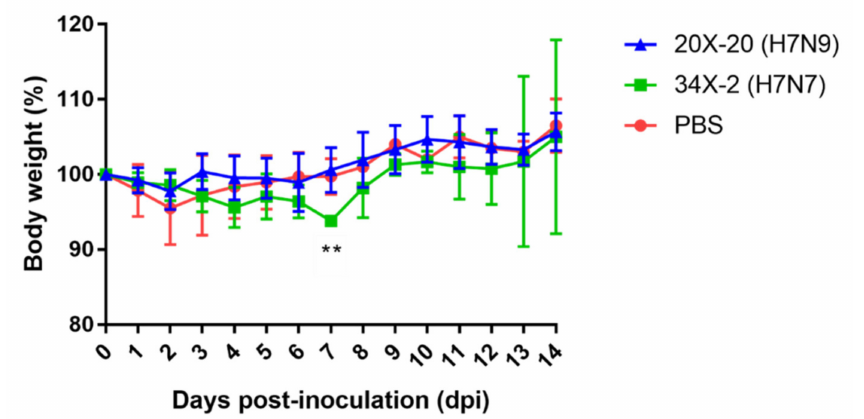
Figure 3. Body weight changes in mice infected with 20X-20 and 34X-2 viruses. BALB/c were intranasally inoculated with 10 7 EID 50 of each virus. The mice were observed for 14 days. The data indicate the mean and standard error of the mean (SEM). The data were analyzed using two-way ANOVA with Tukey’s multiple comparisons test. The asterisks show that the body weight of 34X-2 is significantly different from that of 20X-20 and the PBS group (** p <